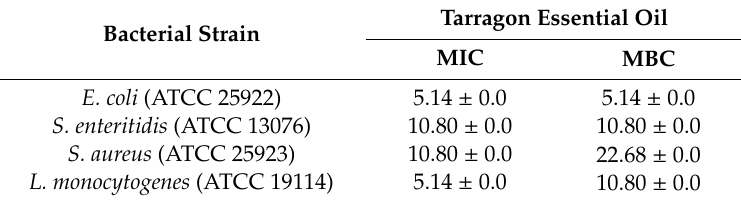
Table 3. Minimum inhibitory concentration (MIC, µ L EO mL − 1 ) and minimum bactericidal concentration (MBC, µ L EO mL − 1 ) of tarragon essential oil. Bacterial Strain